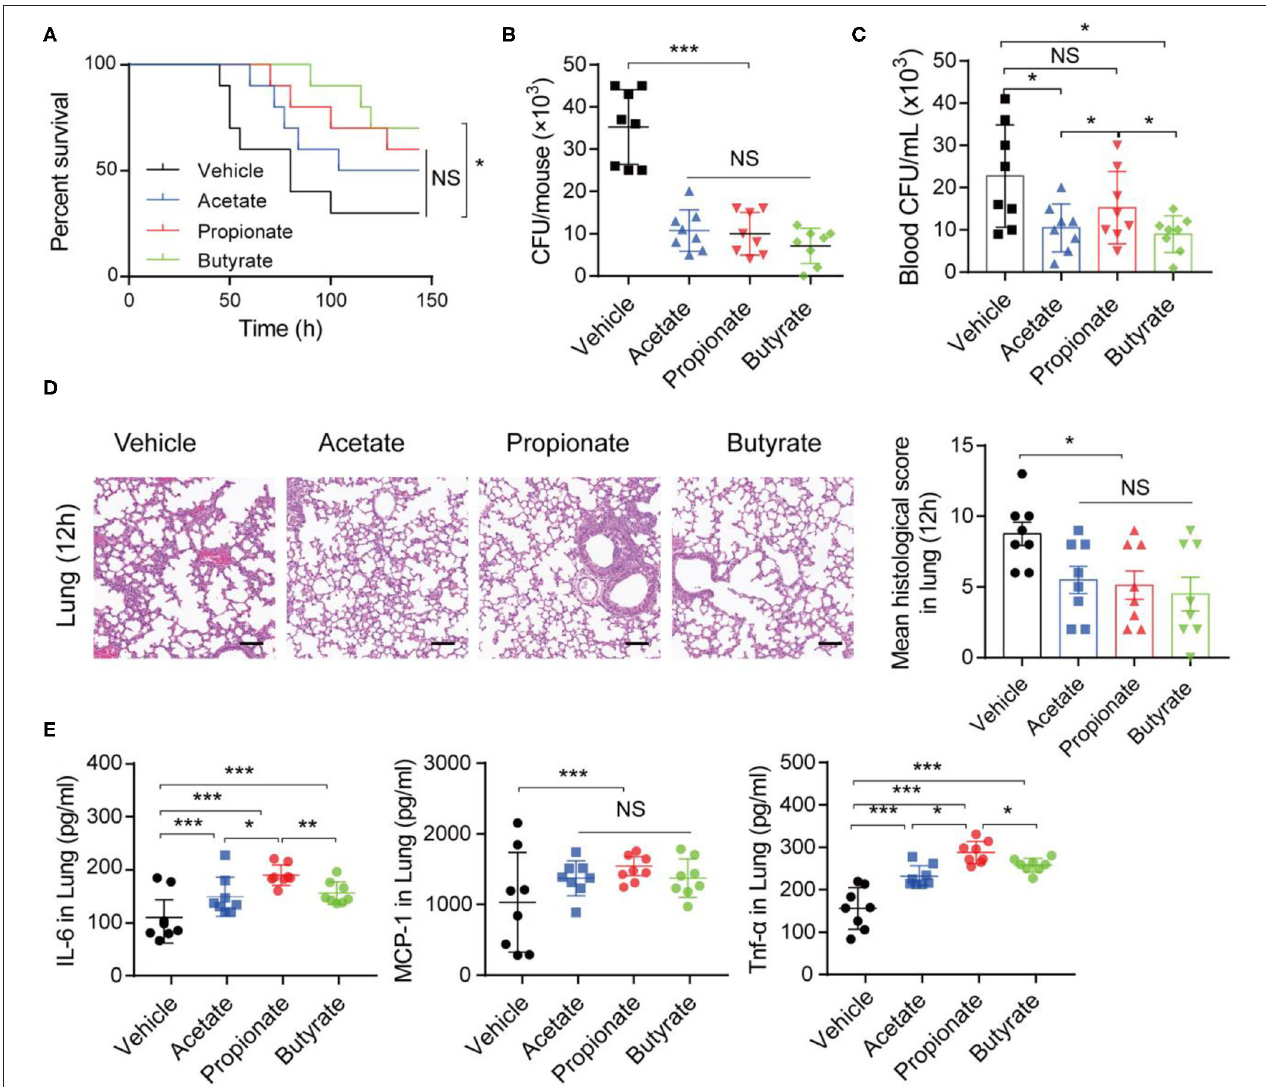
FIGURE 5 | SCFAs promote inflammatory responses during K. pneumoniae -induced sepsis. (A) Survival rates of SCFA-treated mice and untreated controls post 1 × 10 5 CFU of K. pneumoniae infection. (B) Lung and blood (C) bacterial burdens in SCFA-treated mice and untreated controls 12h post K. pneumoniae infection. (D) Representative H&E staining and quantification of pathological scores of lung sections from SCFA-treated mice and untreated controls 12h post K. pneumoniae infection. Scale bars: 50 µ m. (E) Detection of cytokine production in the lung of mice 24h post K. pneumoniae infection by CBA. Data are from one experiment representative of three independent experiments (mean ± s.e.m). Group size is 8–12 per group. P -values are determined by two-tailed Student’s t -tests (B–E) or Log-rank (Mantel–Cox) test (A) . * P < 0.05, ** P < 0.01, *** P < 0.001. NS, not